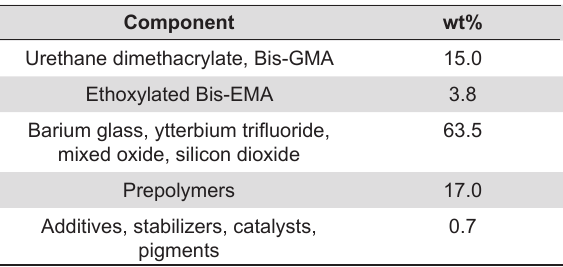
Table 1- Composition of experimental resin composite (provided by the